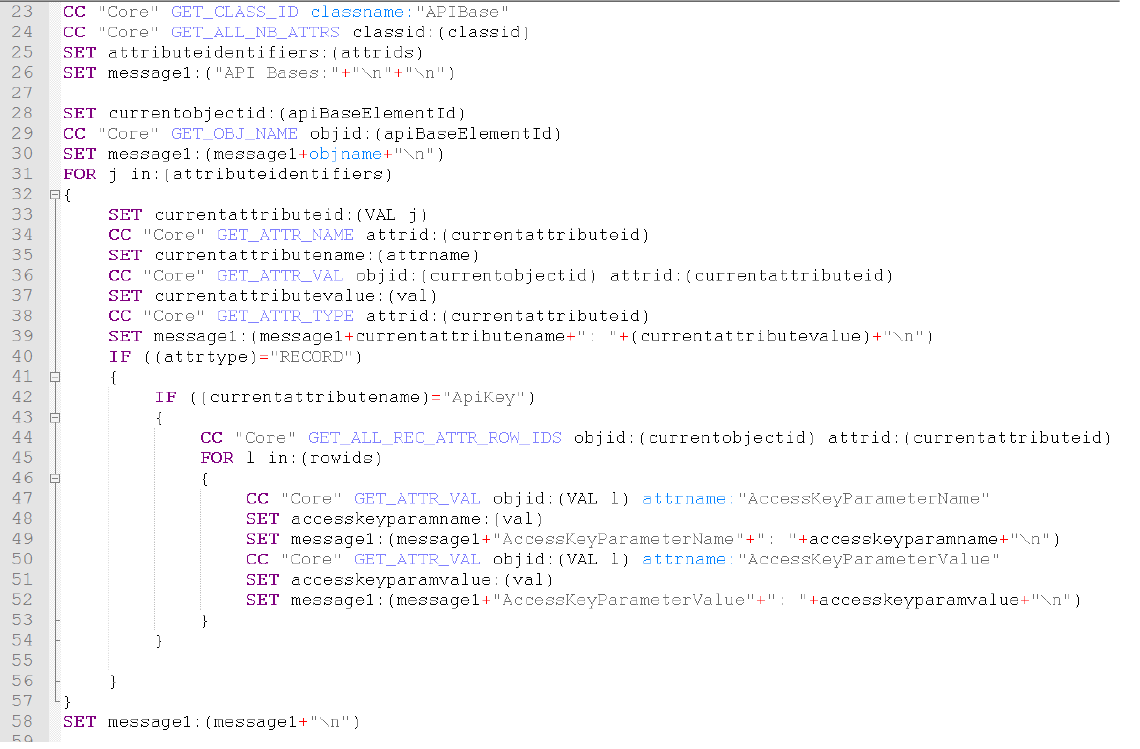
Figure 10. Gathering the attributes of the APIBase class in AdoScript